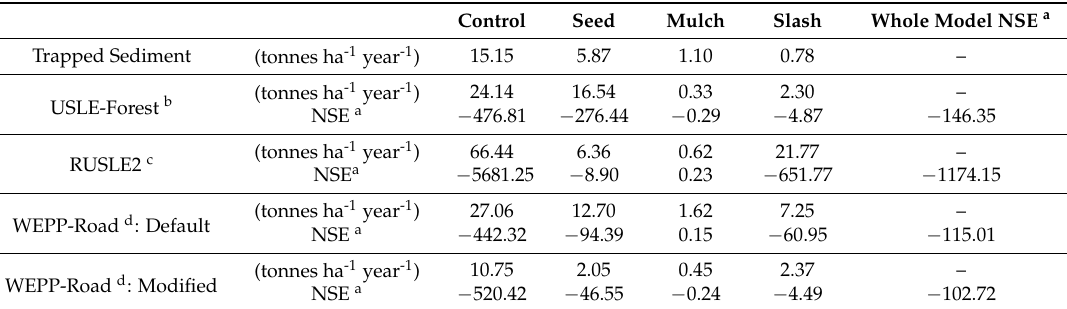
Table 2. A comparison of predicted erosion rates and their Nash-Sutcliffe Model Efficiency (NSE) values for the whole model and for each treatment type.